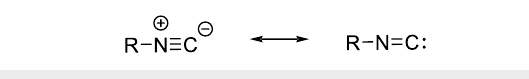
Figure 1: Resonance forms of